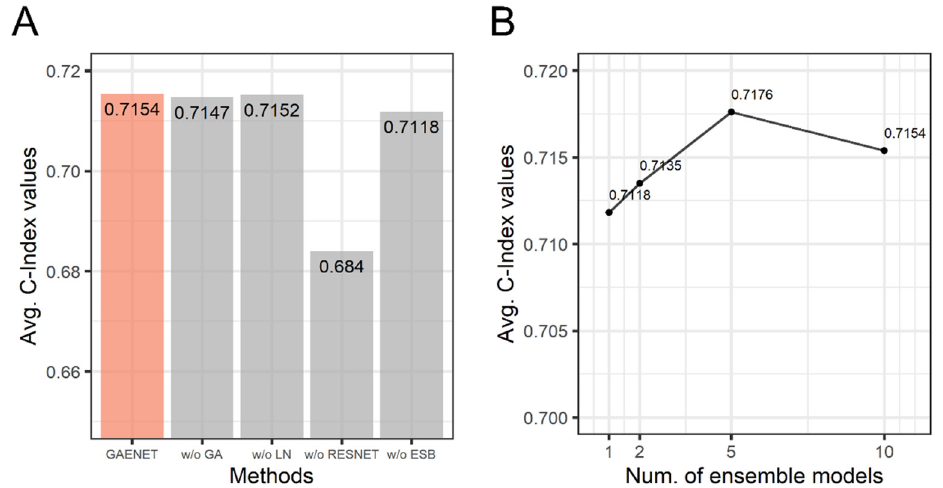
Figure 4. The results of ablation study of the GAENET. ( A ) C-Index values without each method. ( B ) C-Index values with respect to number of sub-models in the ensemble of the GAENET. GA: gene attention; LN: layer normalization; RESNET: residual learning; ESB: ensemble learning.